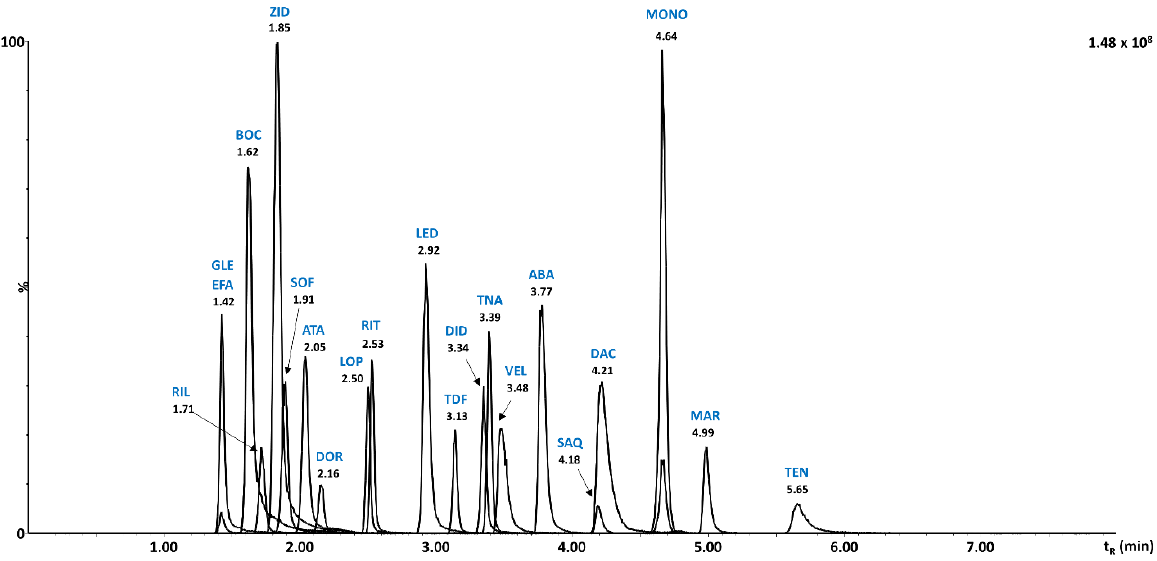
Figure 3. HILIC-UHPLC-MS/MS chromatogram of 21 antiviral drugs using optimized separation conditions: Cortecs HILIC column, 25 mmol/L ammonium formate pH 3 (mobile phase A) and ACN (mobile phase B) in gradient elution with the gradient program 98% to 50% B in 5 min. Medronic acid (0.1 %) was added to both mobile phase components. Injection volume 2 µL and flow rate 0.3 mL/min.